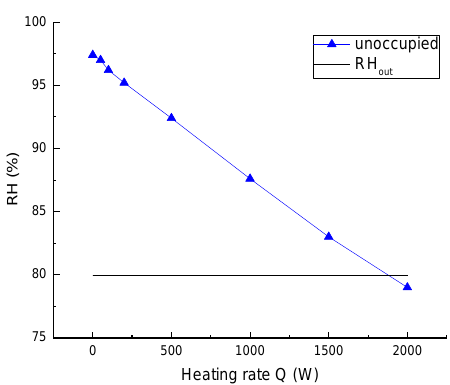
Figure 11. The highest indoor air RH under different heating rates in the unoccupied home.